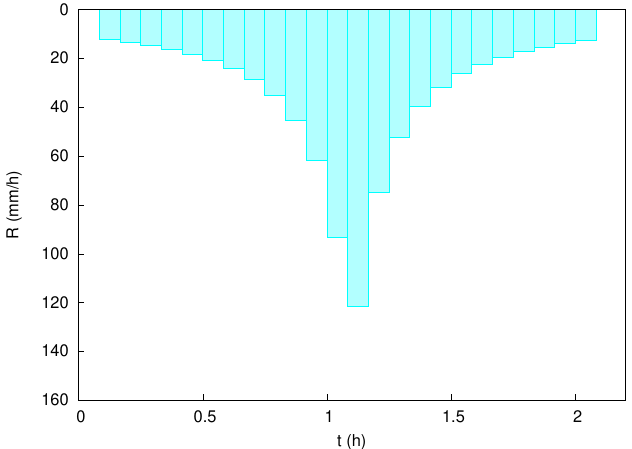
Figure 13. Case 3: Temporal evolution of the incoming rainfall intensity.